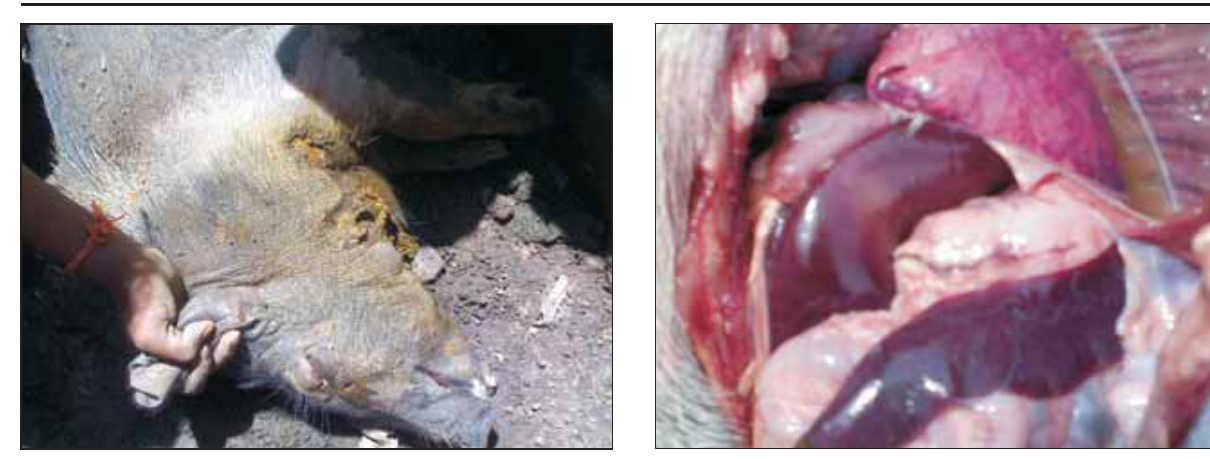
Figure-2: The photograph showing consolidation of lungs, hydrothorax, congested liver and spleenomegaly of pig died of swine